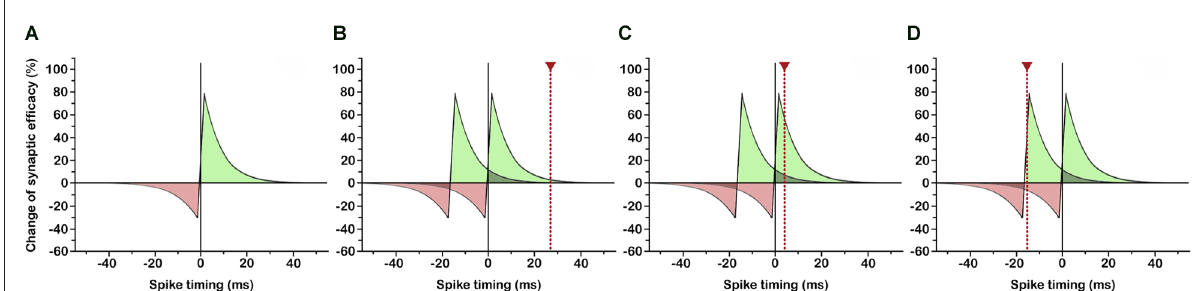
FIGURE1 Learning to respond to the onset of a recurring input pattern through spike-timing-dependent plasticity (STDP). (A) Classical STDP rule: If the presynaptic input signal slightly precedes postsynaptic spiking, synaptic efficacy is enhanced (green area), if postsynaptic spiking occurs slightly before presynaptic input, synaptic efficacy is reduced (red area). Spike timing in ms indicates postsynaptic vs. presynaptic spiking. (B) Initial situation: Two succeeding input signals, possibly arriving at different synapses, are followed by a postsynaptic spike (dotted red line) inside the temporal window for synaptic potentiation. (C) Through an increase in synaptic efficacy, postsynaptic response latency is reduced, so that postsynaptic spiking falls into the temporal window for synaptic potentiation subsequent to the first input signal. (D) Continuing latency reduction of postsynaptic spiking leads to a response to the first input signal (=onset of recurring input pattern) with shortest possible